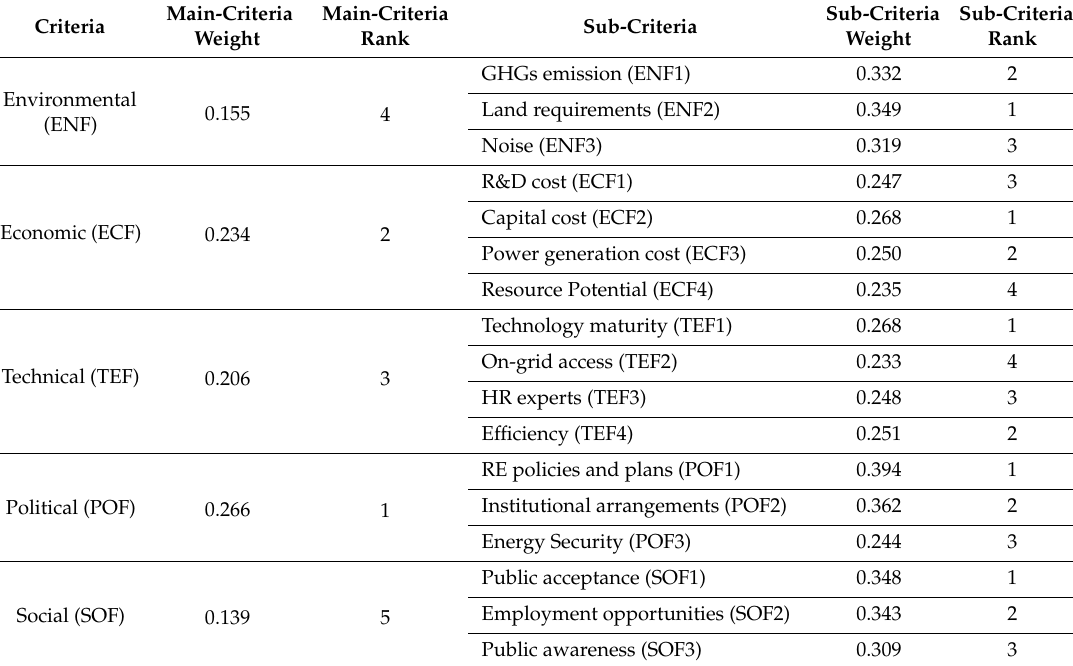
Table 7. Ranking of main criteria and